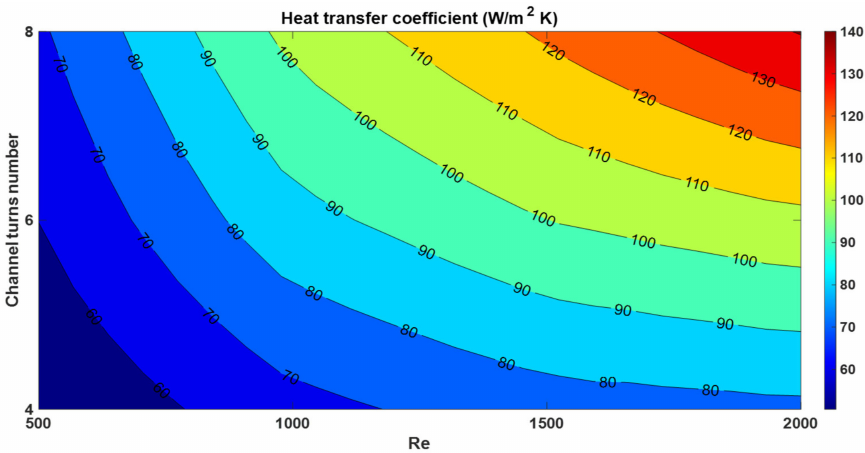
Figure 4. Contour plot of heat transfer coefficient versus channel turns number and Reynolds number for a cooling system using water as the coolant—results were obtained from 12 simulations.